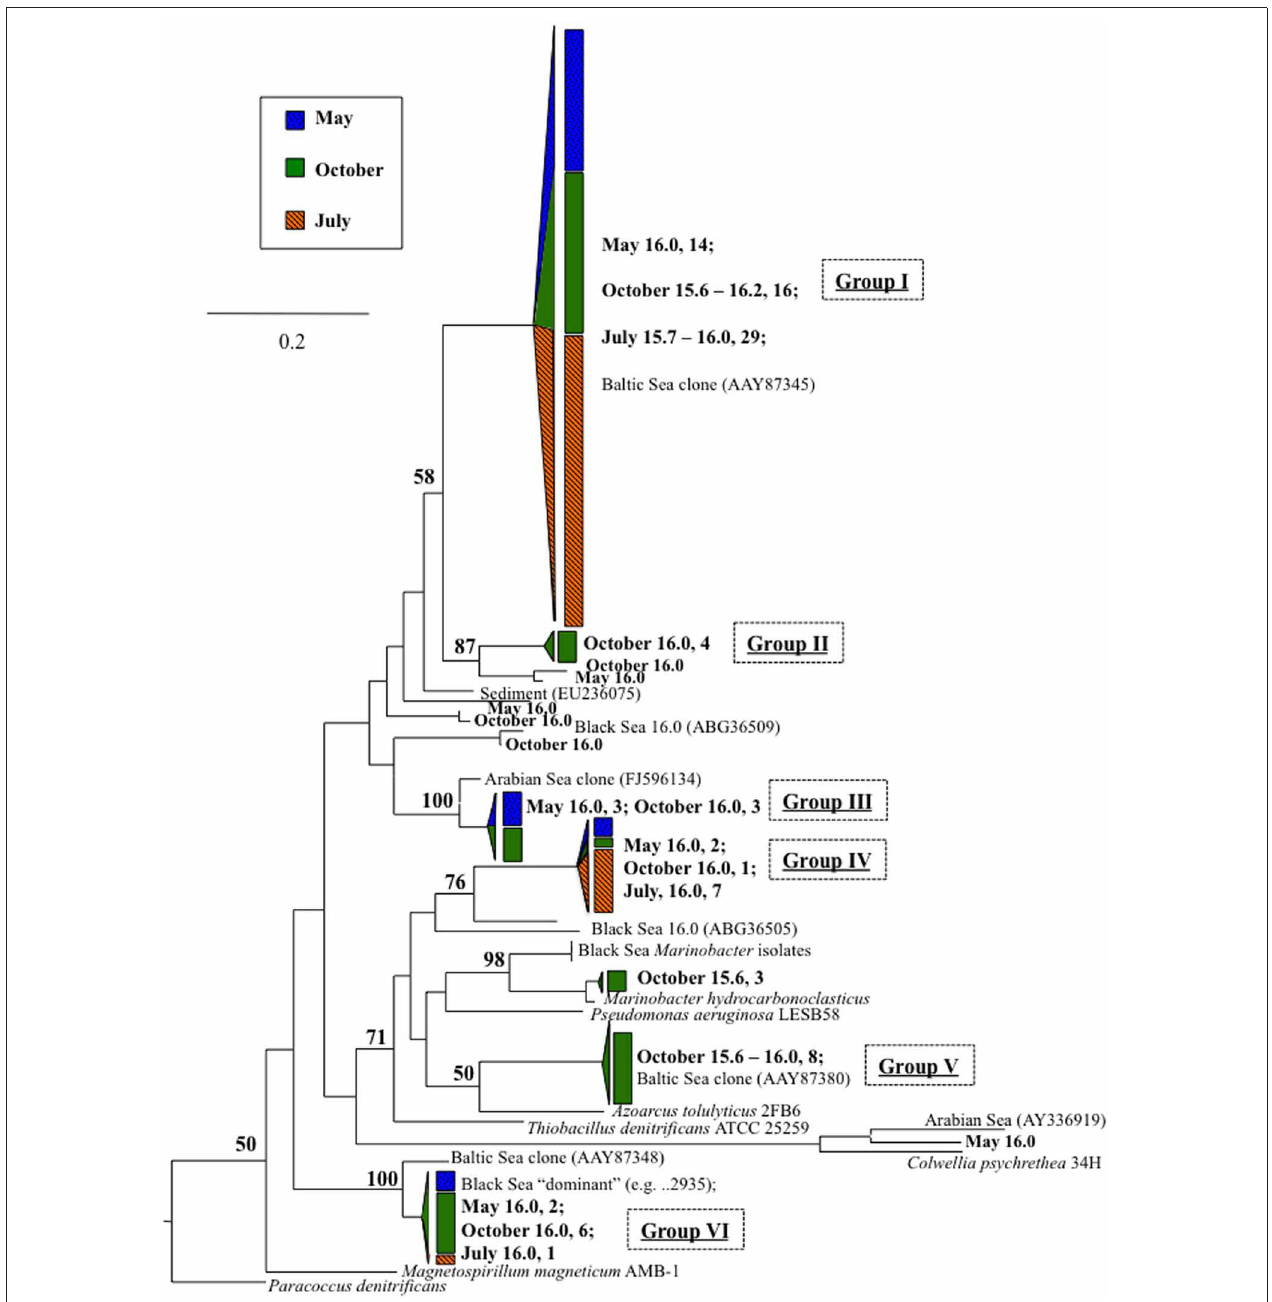
FIGURE 6 | nirS expression as detected with degenerate primers nirS1F/6R (Braker et al., 1998). Numbers indicate density, followed by number of clones. References include cultured strains (in italics), Baltic Sea